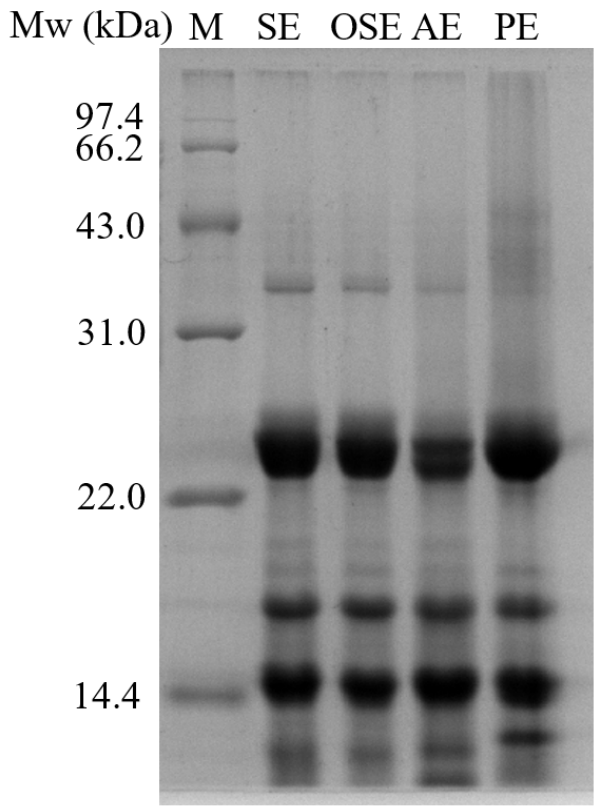
Figure 2. SDS-PAGE of field muskmelon seeds protein extracted by different oil extraction methods.